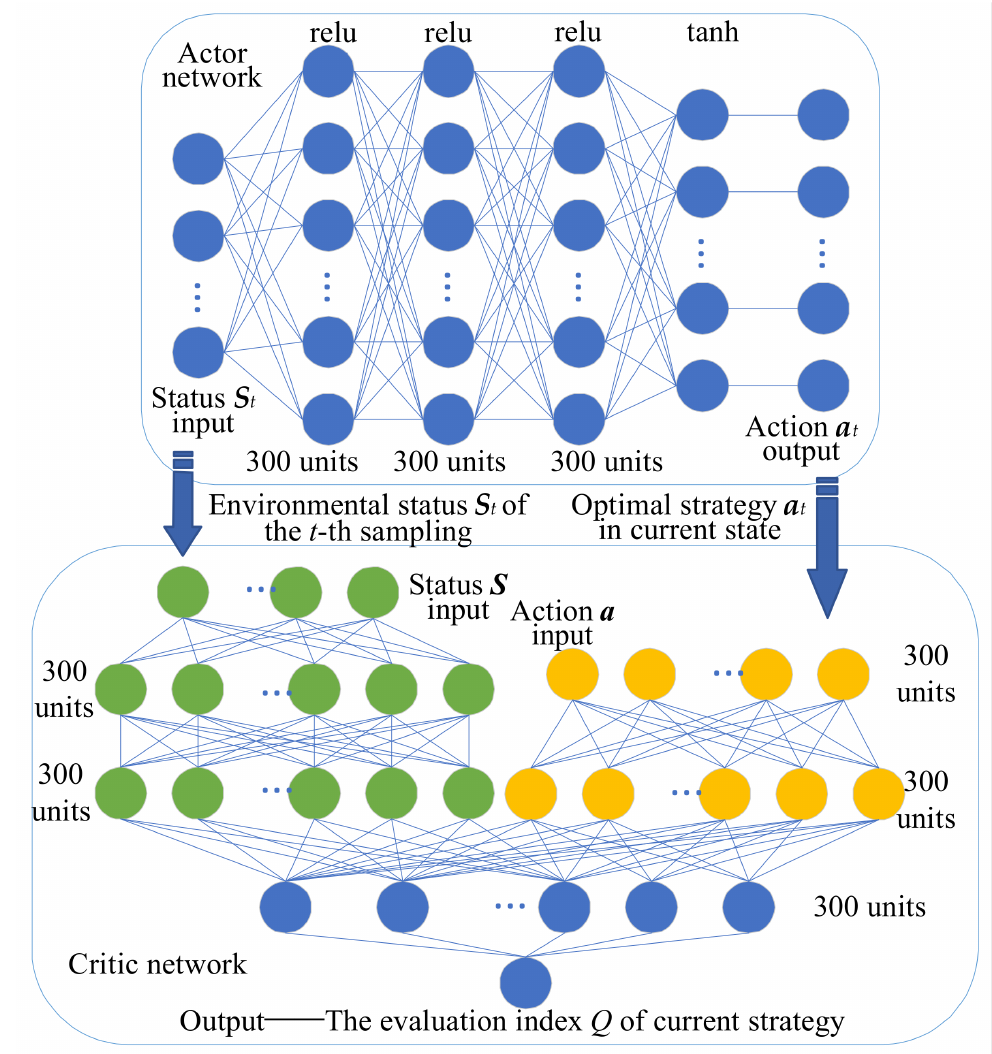
Figure 4. Actor–critic network